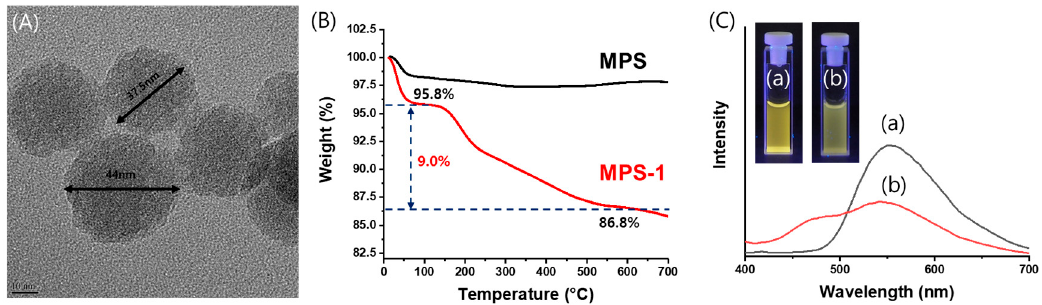
Figure 4. ( A ) Transmission electron microscopy (TEM) image of mesoporous silica ( MPS-1 ) and ( B ) thermogravimetry analysis (TGA) thermogram of MPS (black) and MPS-1 (red). ( C ) The photograph and the Fluorescence spectra of ( a ) MPS-1 (2 mg) in water (2 mL) and ( b ) MPS-1 (2 mg) in 100 ppb UO 22 + solution (2 mL).